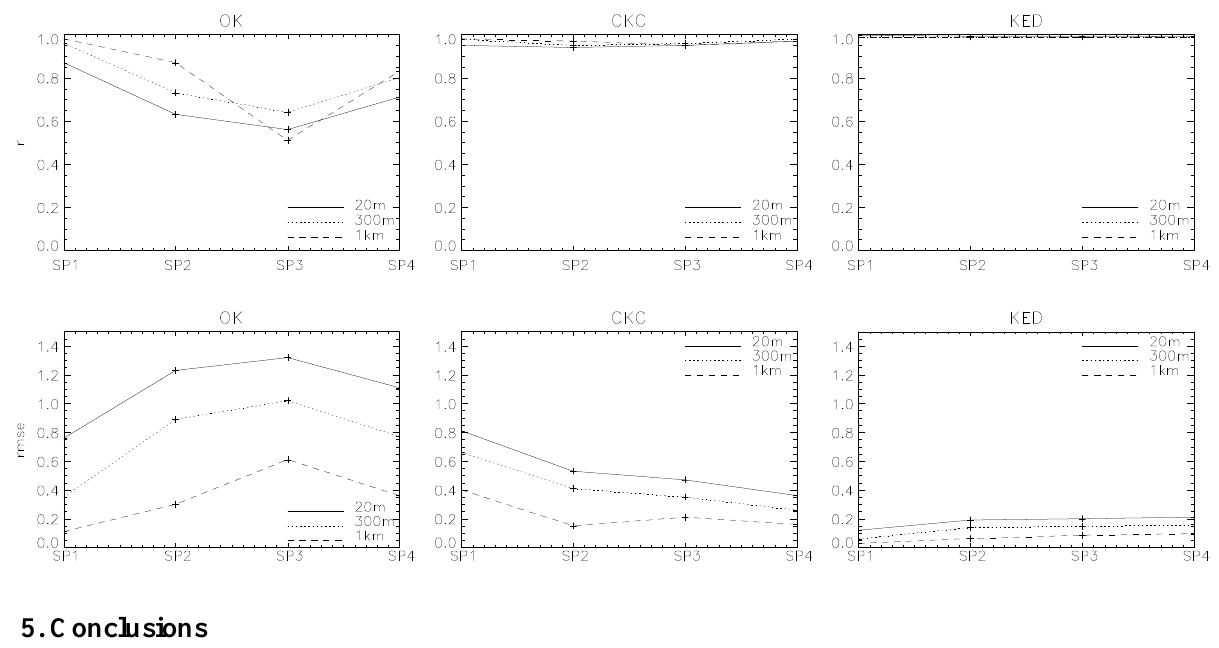
Figure 13. Correlation coefficient and RMSE between the geostatistical and the LAI reference map for the four spatial sampling at high (20 m), medium (300 m) and coarse (1 km) spatial